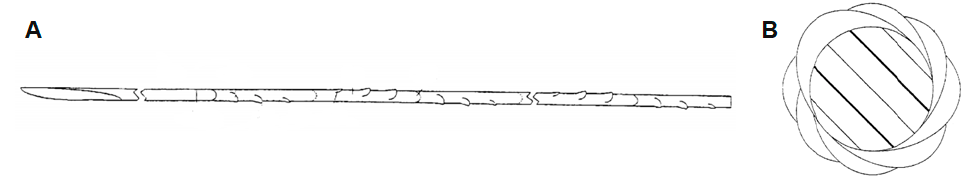
Figure 6. ( A ) Harry Buncke’s unidirectional barbed suture with barbs cut in a conical sequence and ( B ) a cross-sectional view of the barbed suture [22]. ( B ) a cross-sectional view of the barbed suture